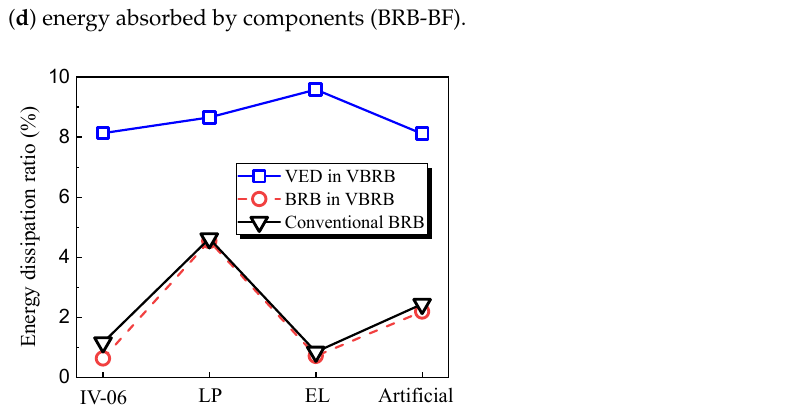
Figure 12. Energy dissipation ratio of the brace (PGA = 70 cm/s 2 ).